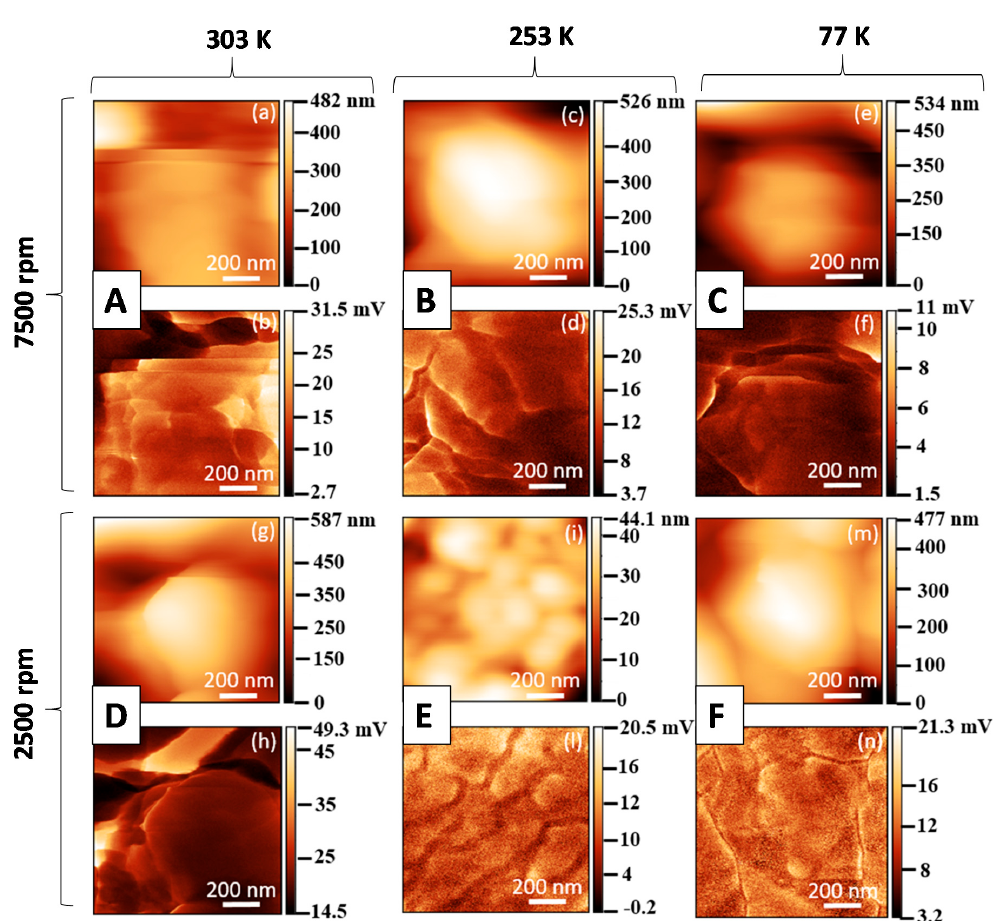
Figure 5. Morphological maps and Piezoresponse Force Microscopy (PFM) signals at V ac = 10 V and at 15 kHz for PVDF at 20 wt.% produced using different temperatures and spinning speeds: ( a , b ) Sample A, ( c , d ) sample B, ( e , f ) sample C, ( g , h ) sample D, ( i , l ) sample E, ( m , n ) sample F.